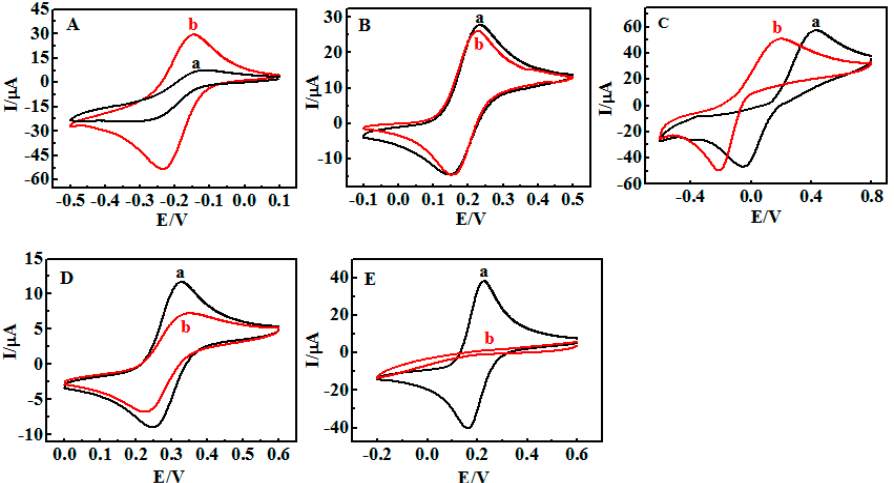
Figure 6. CVs of ( A ) 1 mM Ru(NH 3 ) 6 Cl 3 ; ( B ) 0.5 mM FcMeOH; ( C ) 0.5 mM